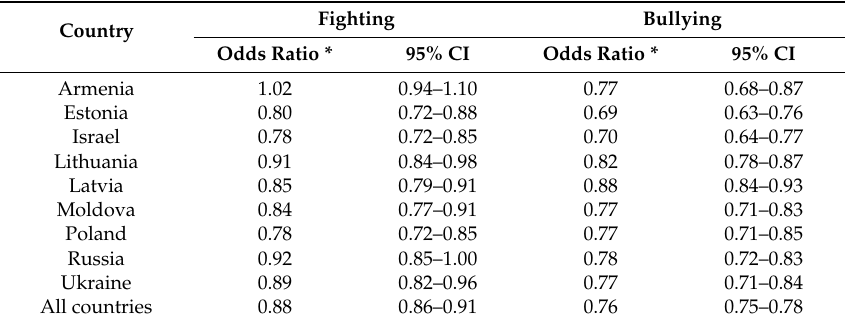
Table 9. Overall social support as protective factor against fighting and